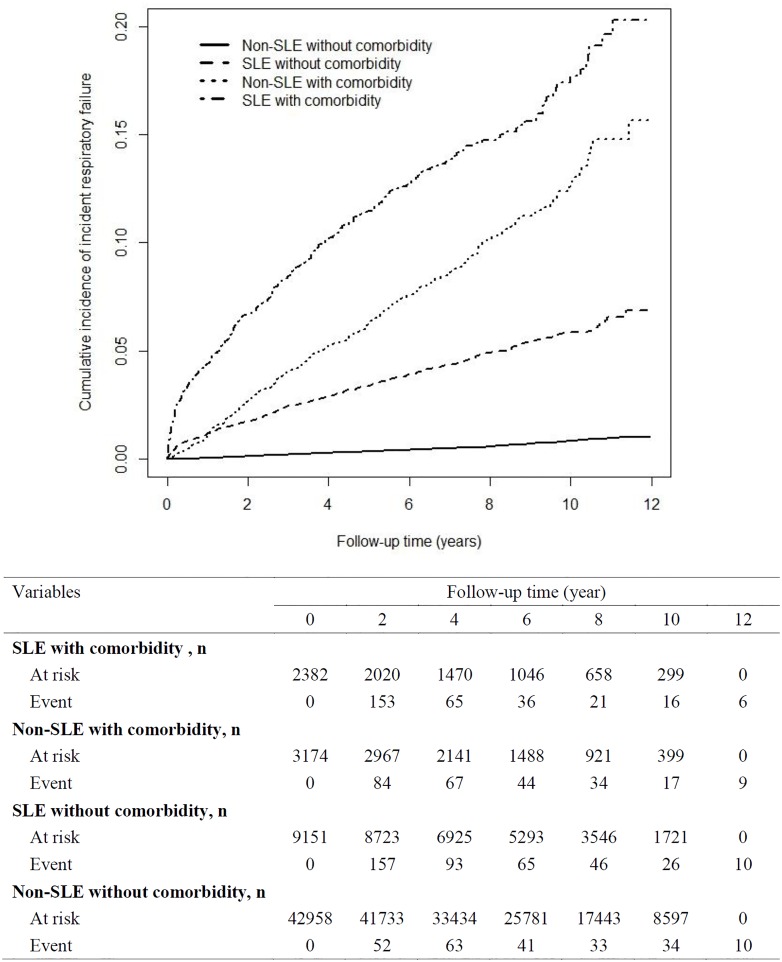
Cumulative incidence of incident respiratory failure in the different subgroups.